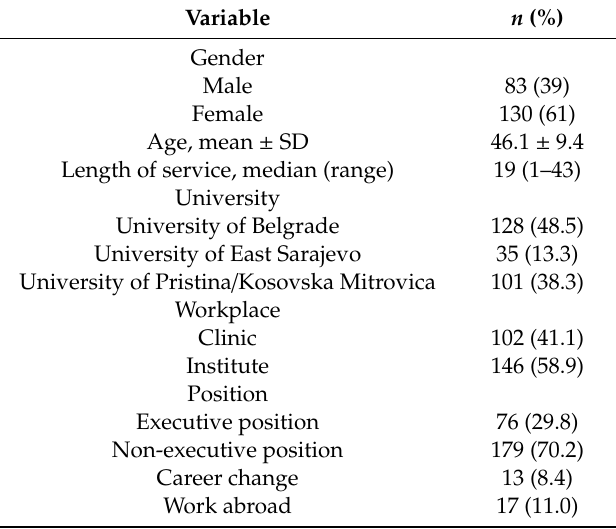
Table 1. Demographic and occupational characteristics of the study